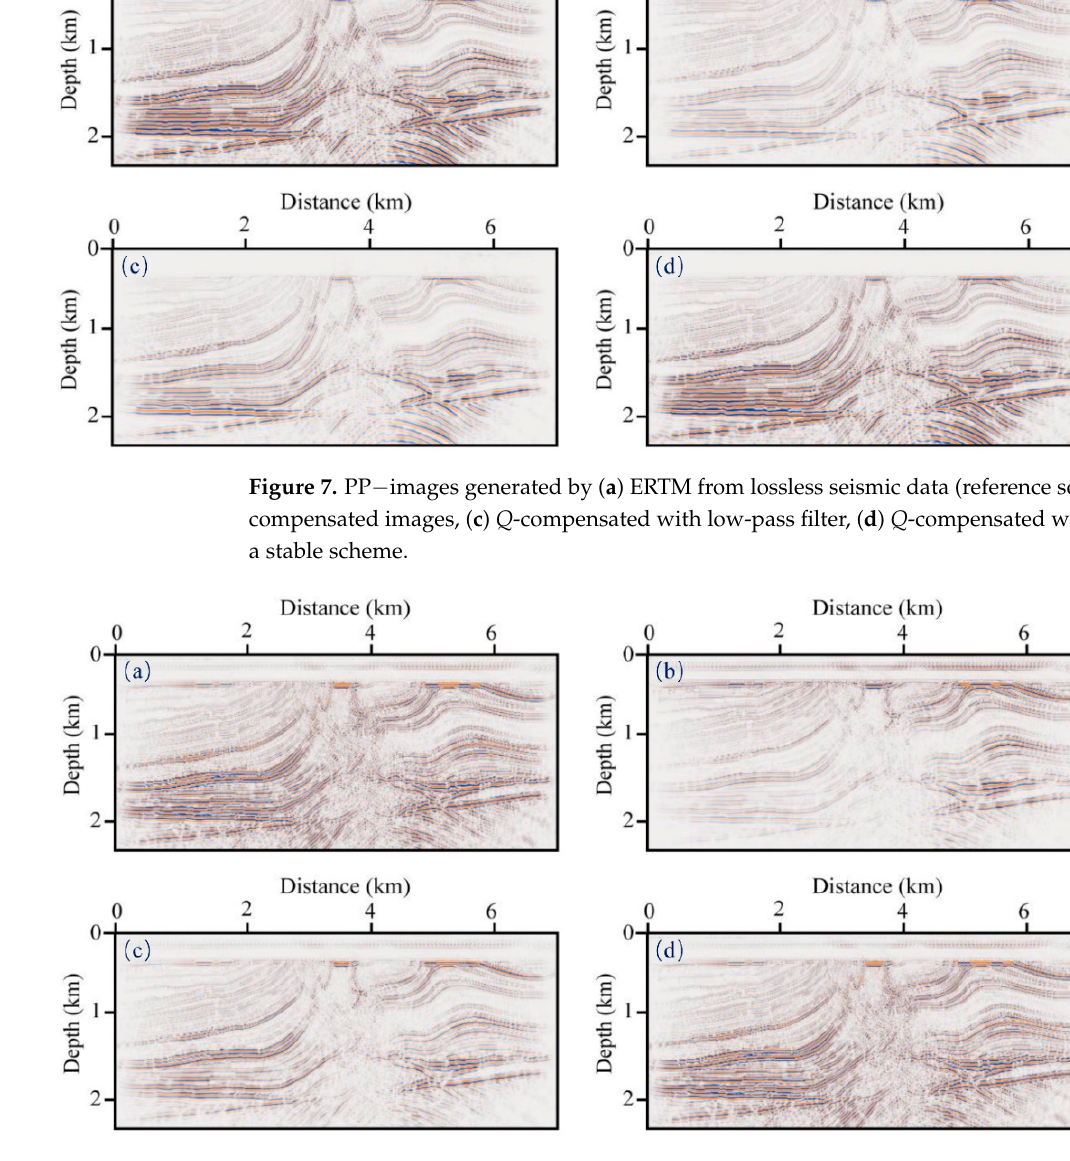
Figure 9. Comparison of the traces at x = 4 km. ( a ) PP − component ( b ) PS-component. 3.3. Apply to Field Data The above synthetic data fully verify the compensation effectiveness of the proposed method. In the last example, we demonstrate its applicability to field data. Figure 10a,b show the velocity and Q model of P − wave, respectively. We also obtain the velocity and Q of S-wave through the conversion formula. The model size is 10 km × 6 km with a spatial sampling interval of 20 m. There are 250 shots distributed laterally at the depth of 20 m. Before implementing migration, we preprocess the initial data with de-noise and surface